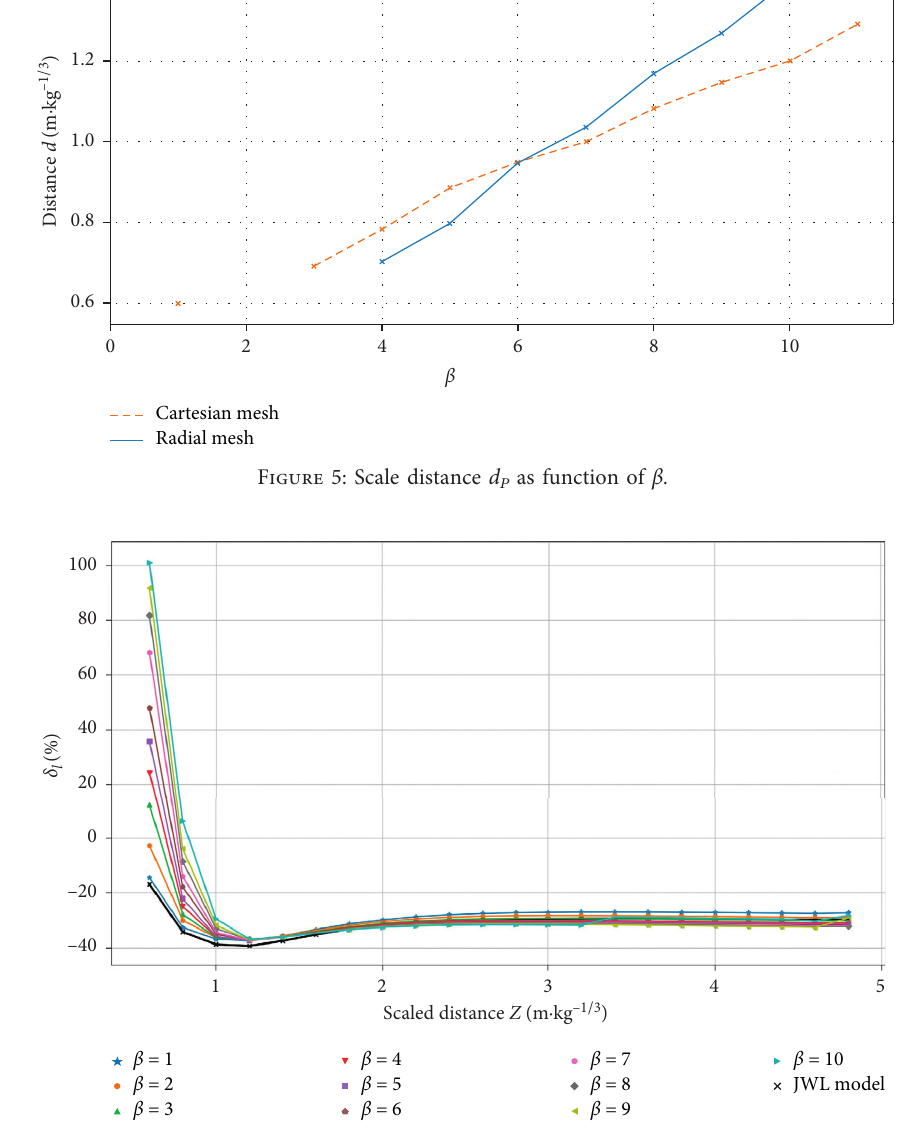
I with UFC-3-340-2 for all β